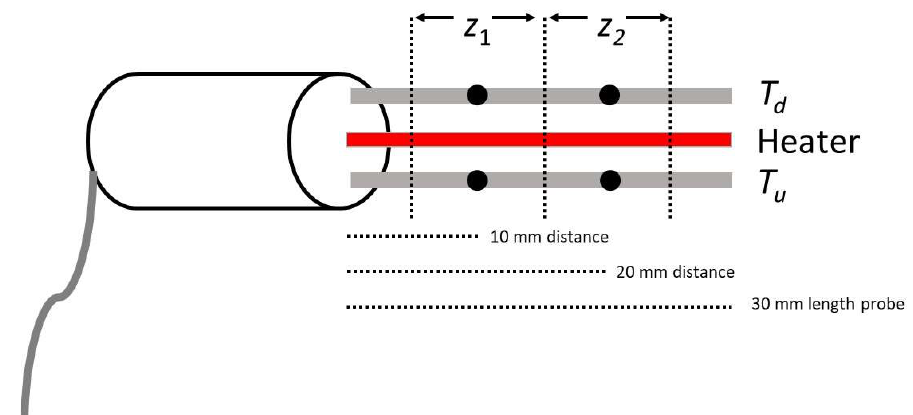
Figure 2. An overview of the Heat Pulse Velocity Sensor’s (HPV-06) design. The positions z 1 and z 2 indicate the outer and inner measurement zone, respectively, with an effective measurement radial radius of 5 mm. T d and T u represent the downstream and upstream temperature probes, respectively. Each black enclosed circle represents a thermistor measurement point. The central probe is the heater. The distance between T d or T u and the Heater was 6